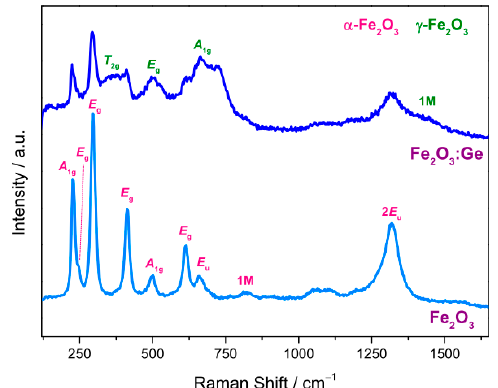
Figure 2. Micro-Raman spectra of the electrospun NFs, as resulting from the average on different